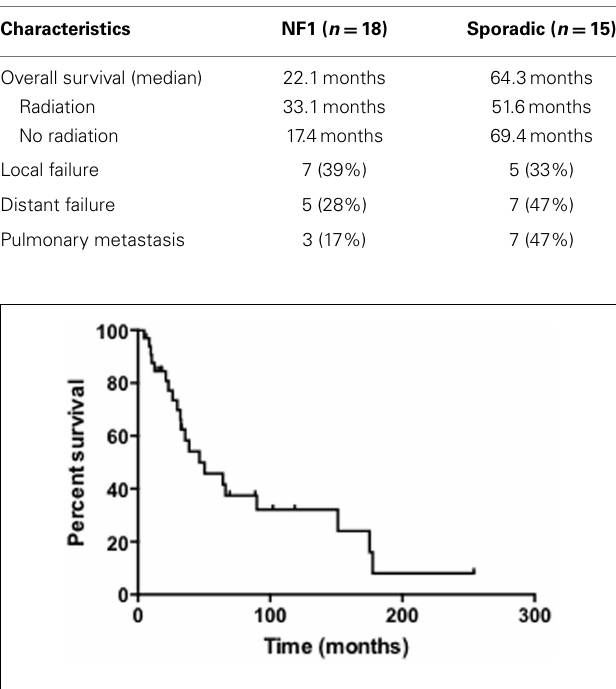
FIGURE 1 | Overall survival of patients with MPNST